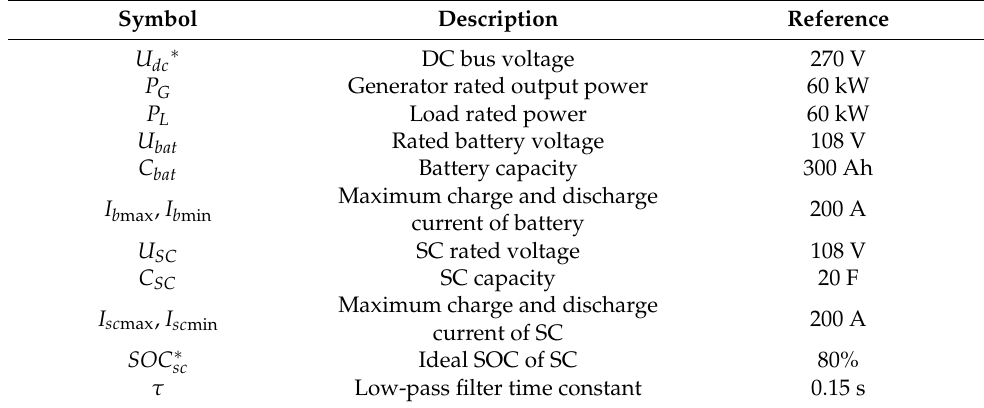
Table 1. Simulation parameters.